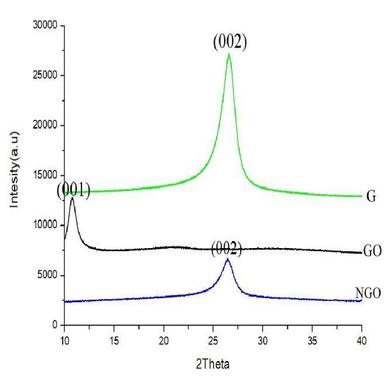
XRD pattern of the prepared samples.